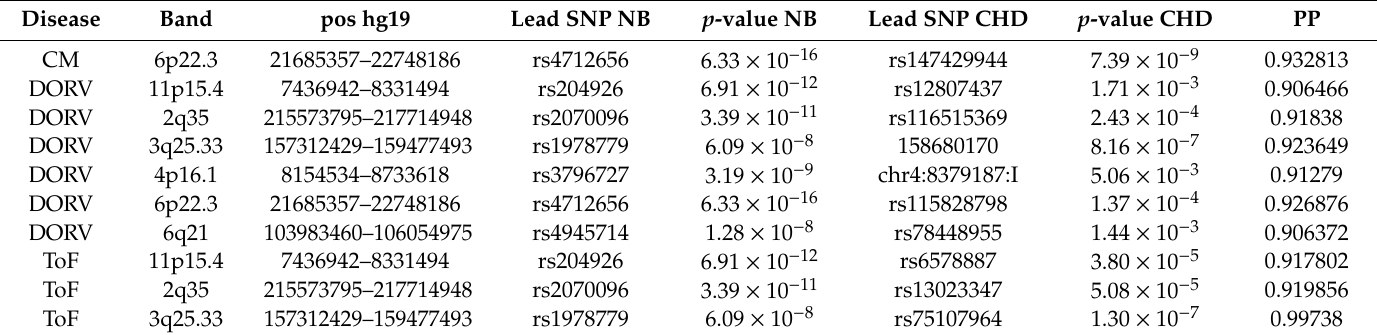
Table 5. Regions of spurious colocalization between NB and diverse CHD